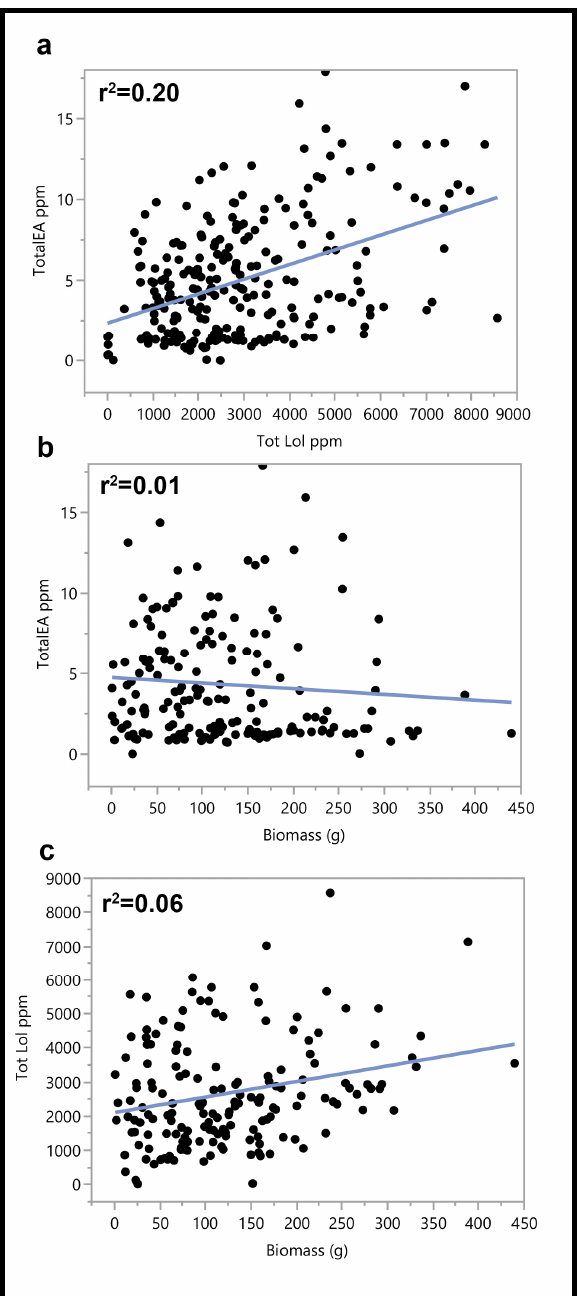
Figure 5. Correlation between accumulation of ergot and loline alkaloids ( a ); correlation between ergot alkaloid ( b ) and loline ( c ) accumulation and biomass over the 2017–2019 period.